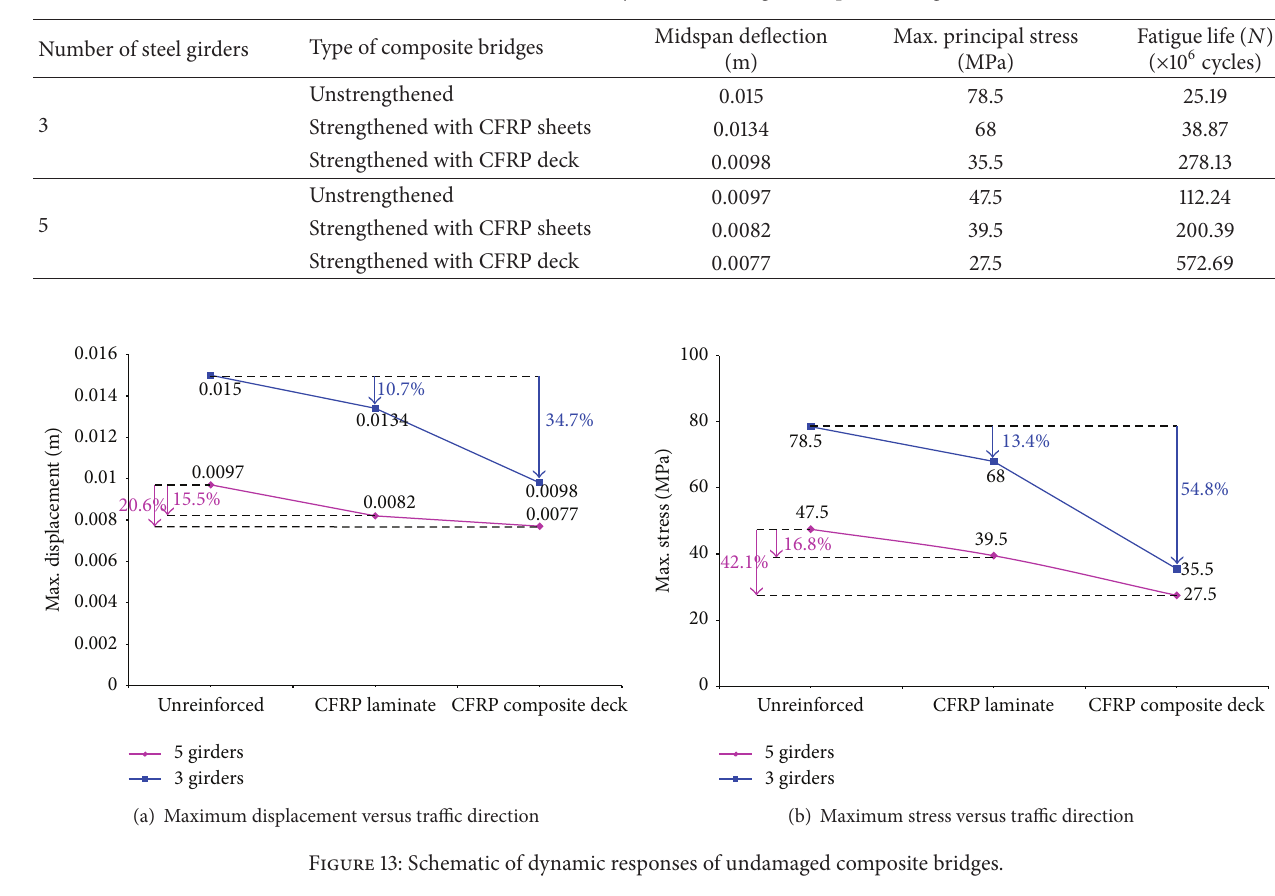
Table 5: Full results of FE analyses of undamaged composite bridges.